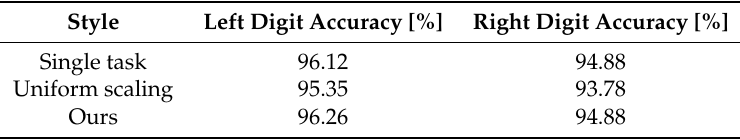
Table 1. Performance of MTS algorithm on Multi